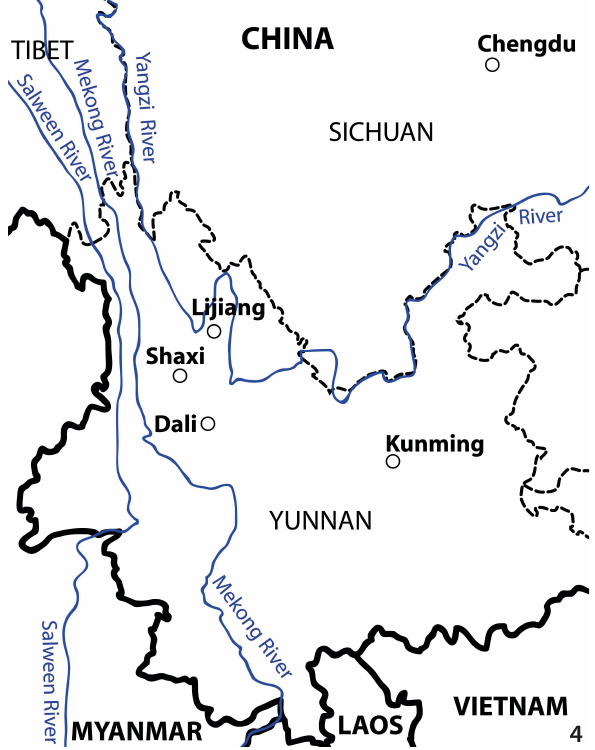
Figure 4 Yunnan–Sichuan map with location of Shaxi (Source: the au-